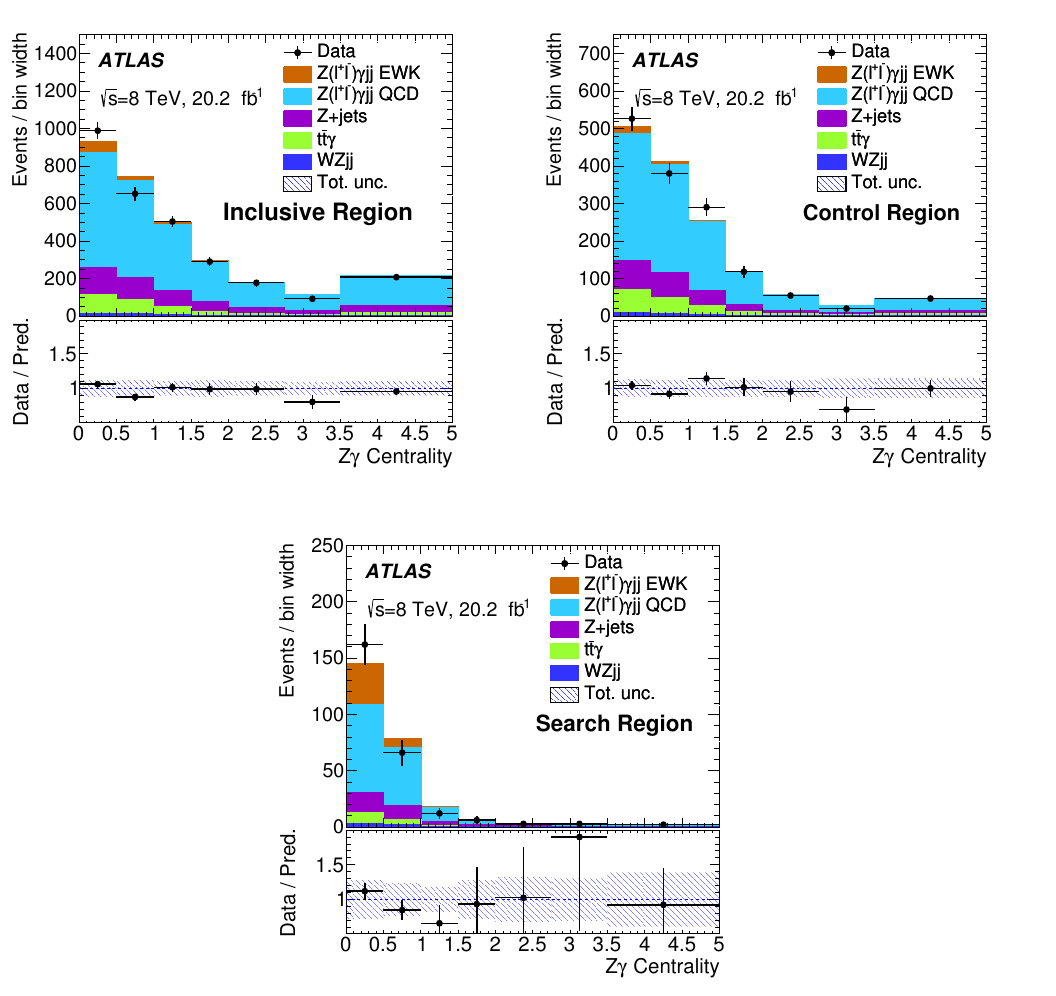
Figure 5 . Distributions of centrality of the Z(cid:13) system, (cid:16) Z(cid:13) , for the electron and muon channels added together in the inclusive region (top left), in the control region (top right) and in the search region (bottom), for the data (black points), and for the signal process and various background components (coloured templates) before any (cid:12)t is done. The ratio of the data to the sum of all pre- (cid:12)t expected contribution (\Pred.") is shown below each histogram. The hatched blue band shows the systematic and statistical uncertainty added in quadrature (\Tot. unc.") in the signal and background prediction, while the error bars on the data points represent the statistical uncertainty of the data set. The number of events in each bin is divided by the bin width. The last bin also includes events beyond the range